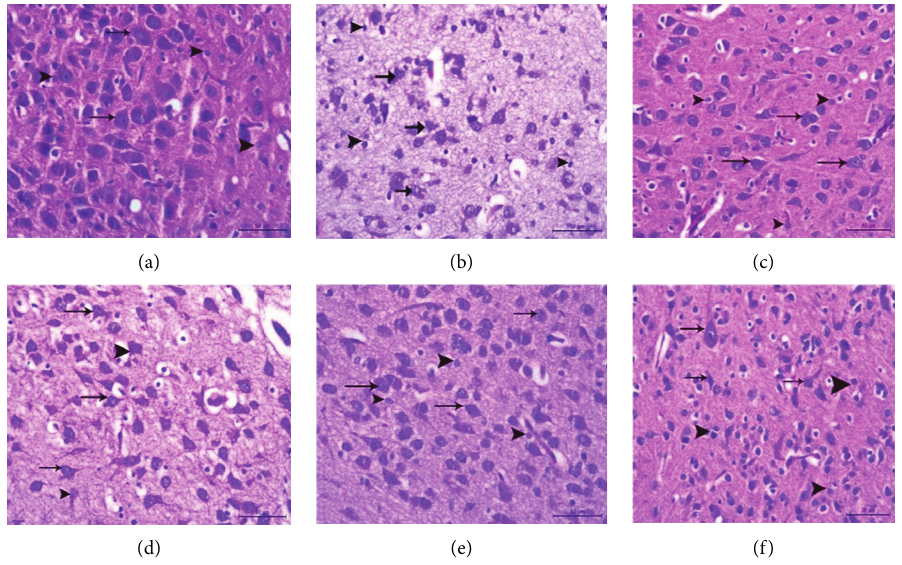
Figure 4: A higher magnification of brain tissue in adult male albino rats showing the groups. (a) Control group, showing normal nerve cells with a large spherical vesicular nucleus and basophilic cytoplasm (arrow). The neuroglia cells (arrow head) appeared normal and adjacent to the neurons. (b) N group, the majority of nerve cells appeared degenerated (arrow) the neuroglia cells (arrow head) appeared suffering from degeneration and necrosis. (c) NNG group, both nerve cells (arrow) and neuroglia (arrow head) appeared normal. (d) N+E group, nerve cells appeared normal (arrow) while other neurons suffered from degeneration (arrow head). (e) N +NNG group, the majority of neurons seemed to be normal (arrow) and the neuroglia cells appeared normal around neurons. (f) N +NNG+E group, the neurons (arrow) and the neuroglia cells appeared normal. H&E stain X